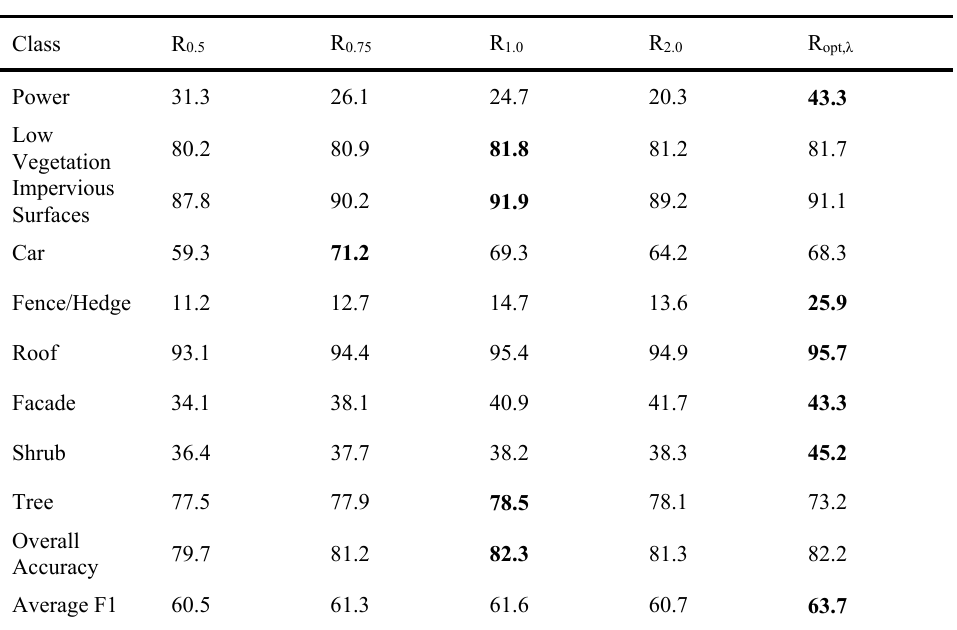
Table 1. The recall value, the overall accuracy of each class and average F1 value for different neighborhood scale in [%]. Bold numbers show the highest values within the different